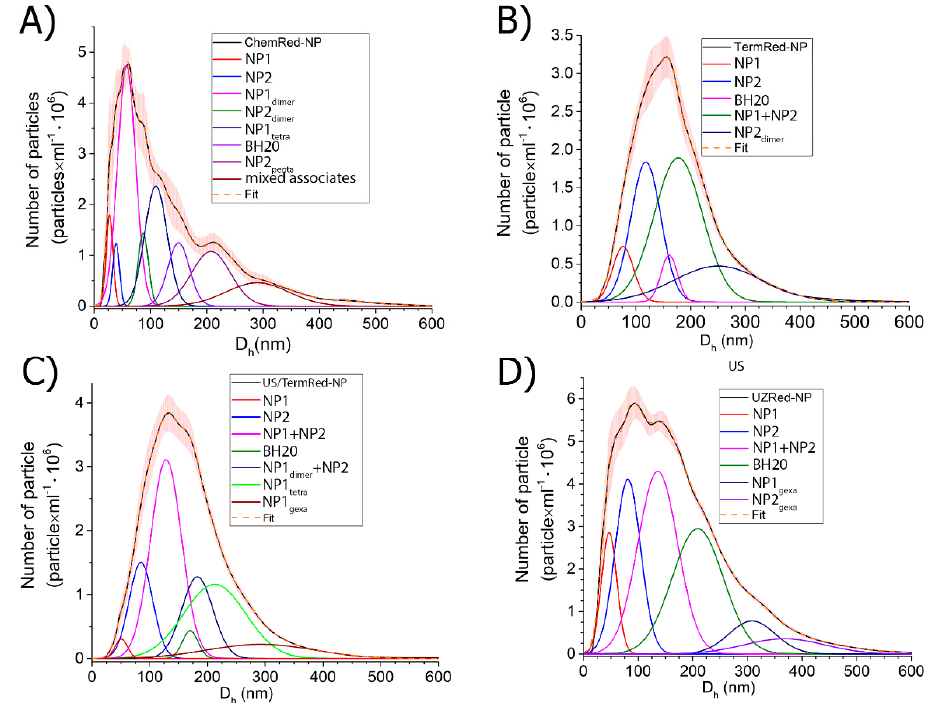
Figure 9. NTA analysis of nanocomposites dispersion: ( A ) ChemRed-NP (RMSE = 0.9995; χ 2 = 7.6 × 10 − 4 ); ( B ) TermRed-NP (RMSE = 0.9998; χ 2 = 1.5 × 10 − 4 ); ( C ) US/TermRed-NP (RMSE = 0.9999; χ 2 = 3.3 × 10 − 5 ); ( D ) US-NP (RMSE = 0.9993; χ 2 = 6.5 × 10 − 4 ) in aqueous solutions ( с NP = 0.1 mg·mL − 1 ). Thus, the distribution of the nanocomposites in the solid phase obtained by TEM and SEM correlates with the distribution of the nanocomposites in solution (Table 1). Table 1. Dependence of the size (Dh) of a particle of iron-based composite nanomaterials obtained by various methods, according to NTA, SEM data, and their concentration in a solution. D h ( mean ) by D h ( mode ) by Sample NTA; ( nm ) NTA; ( nm )